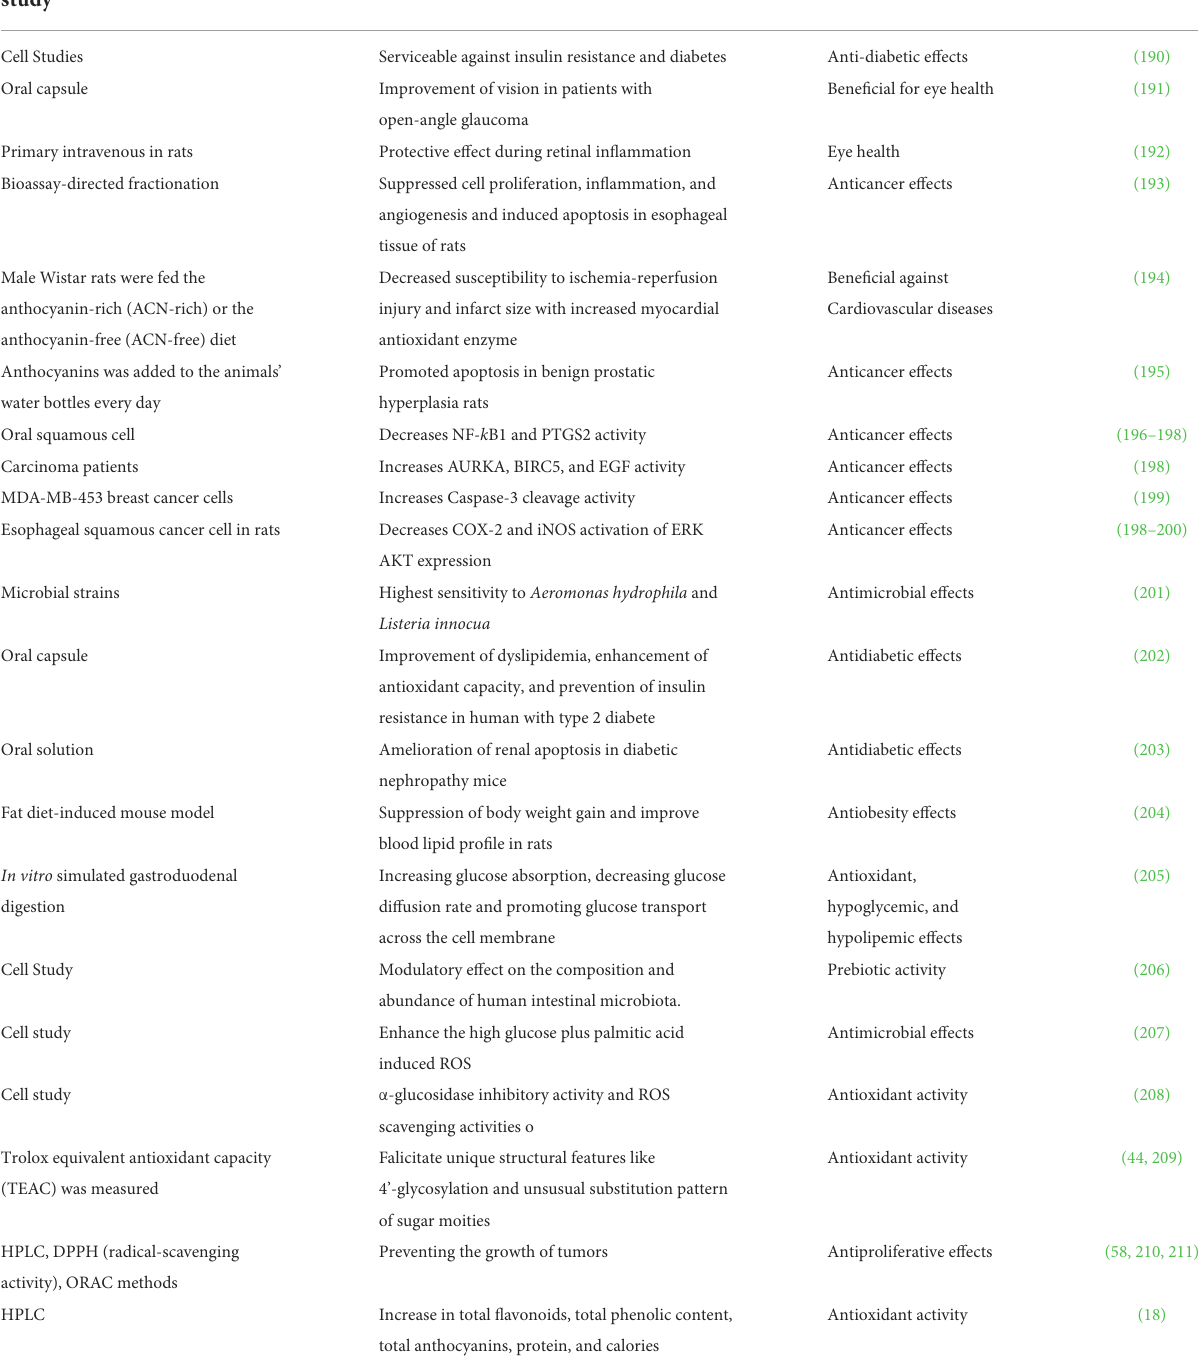
TABLE 2 Biological activities of anthocyanins and their health